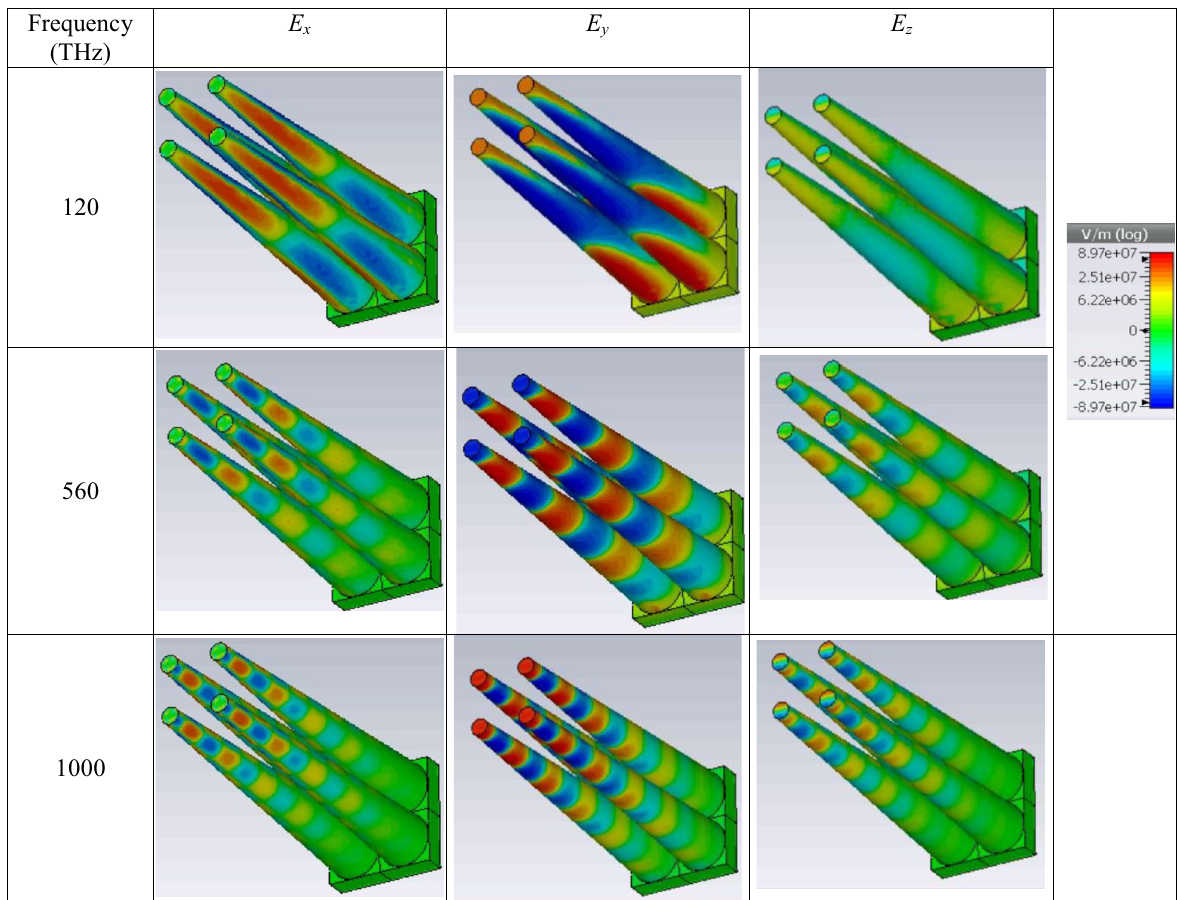
Table 1. Spatial distribution of the electric field at three different frequencies.